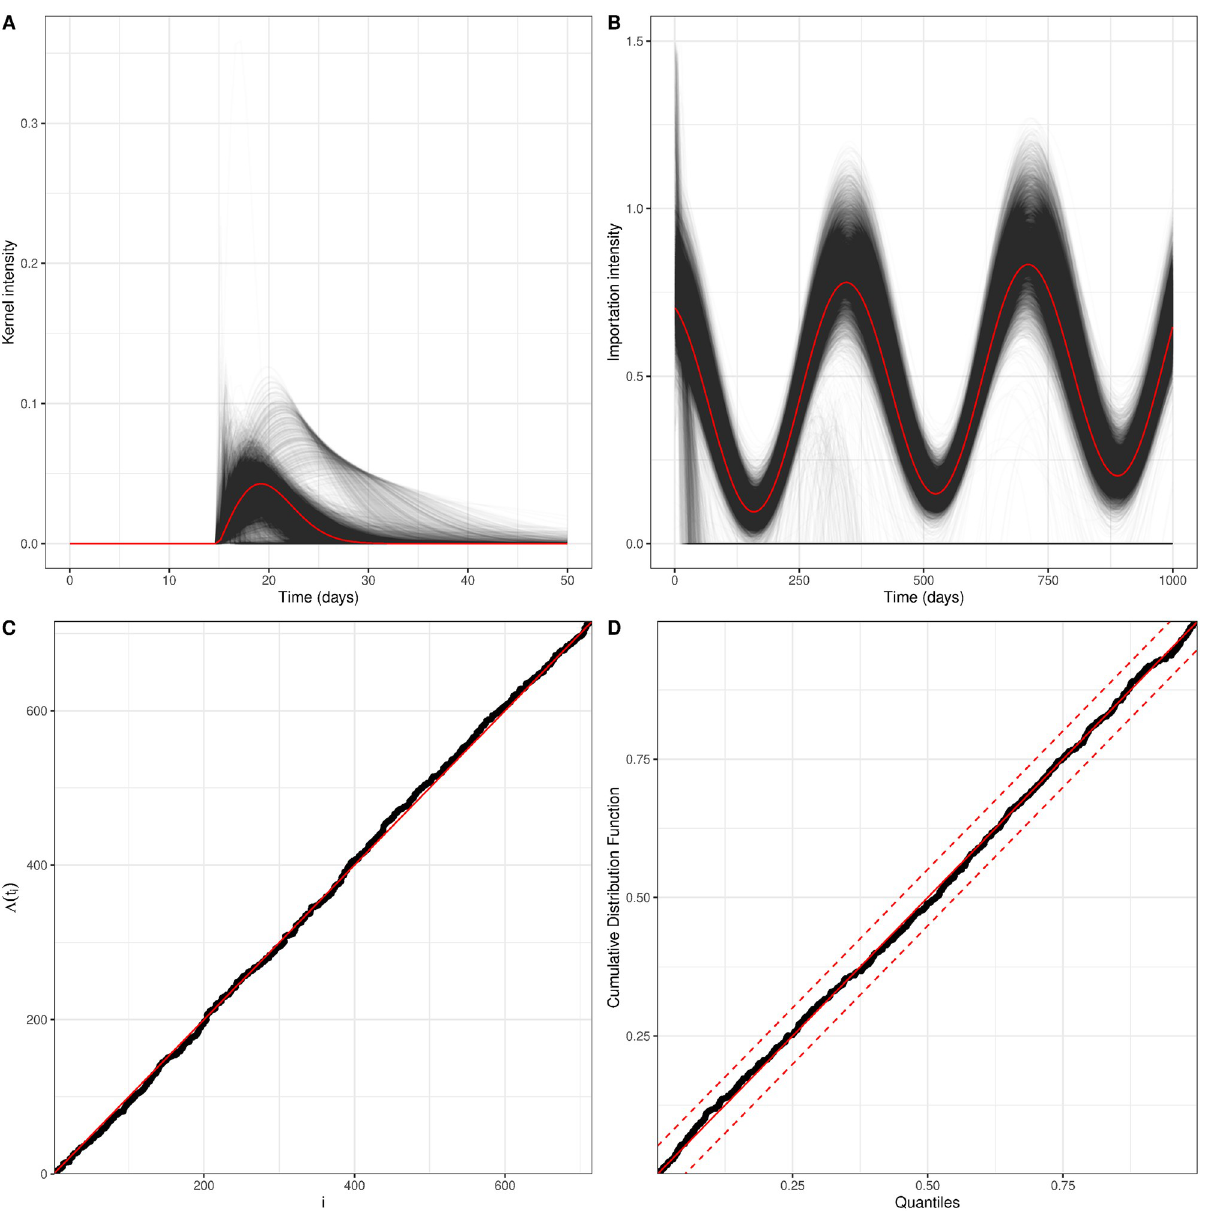
Fig 2. Model fits for simulated data using parameters: α = 0.017, δ = 0.057, A = 0.400, B = 0.0001, M = 0.305, N = − 0.123 and our fixed delay Δ = 15. Fig 2A shows the kernel from the true parameter in red with the kernels generated from the refits to each simulation in black. Fig 2B shows the how the exogenous term or importation intensity varies through time. The red line shows the importation intensity calculated from the initial parameters and the black lines shows the importation intensity calculated from the parameters fit from each simulation. This figure is magnified to show the region around the true value, but the un-magnified version is given in S1 Fig. Fig 2C shows the integral of the intensity evaluated at each event time plotted against the event index, for one simulation. The red solid line is y = x . Fig 2D shows the KS goodness of fit test from one simulation. The red solid line is y = x and the red dashed lines represent the 95% confidence